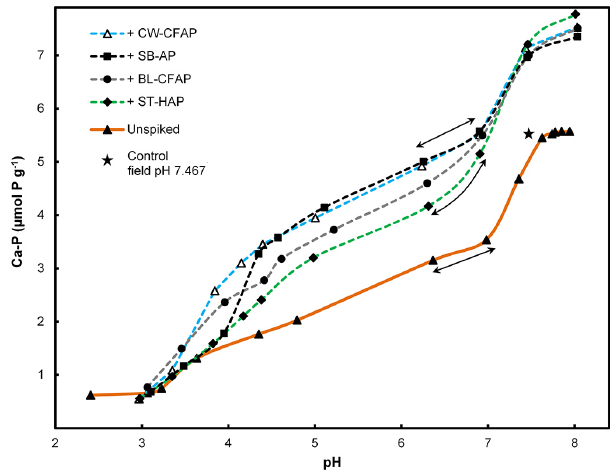
Figure 7. Increase of Al / Fe-P due to calcium phosphate dissolu- tion (subsequent adsorption; pH 4–8) and decrease of Al / Fe-P due to desorption (pH < 4) as determined by subsample incubation of sediment (unspiked and with reference mineral additions) and sub- sequent fractionation (CONVEX method). Note the mirror-like re- flection in the pH range 4–8 when compared to Fig. 2a (except for unspiked sediment; see text). Analysis was performed using sedi- ment from the Firth of Thames, New Zealand. Control: fractionation without prior incubation. See Table 1 for origins of added standard